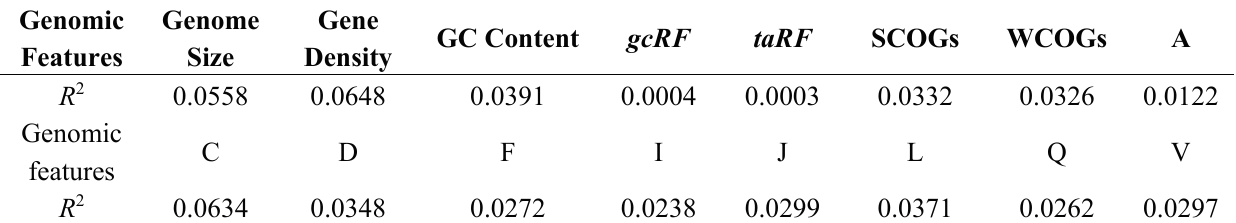
Table 6. Principal component regression analysis of various genomic features a